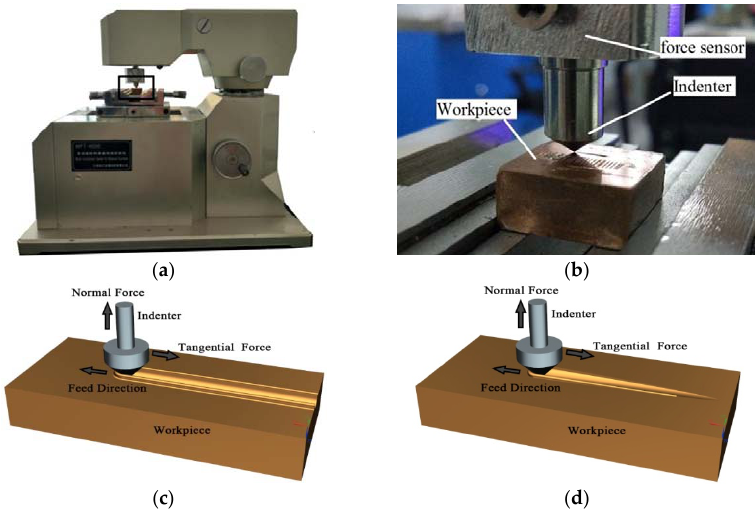
Figure 1. The experimental equipment and principles. ( a ) The multifunctional material surface tester; ( b ) Experimental set ‐ up; ( c ) Sketch of constant loading scratching; ( d ) Sketch of linearly loading scratching. Table 1. The fundamental performance parameters of the tester.